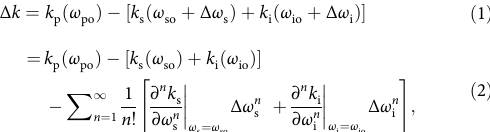
n 2 is the nonlinear refractive index and P cr is the critical power for